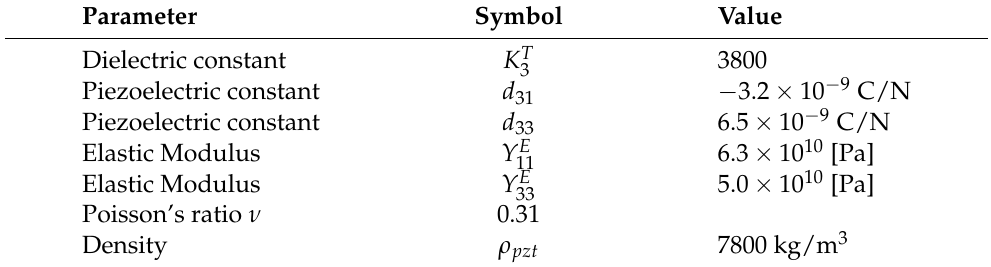
Table A3. PZT 5H